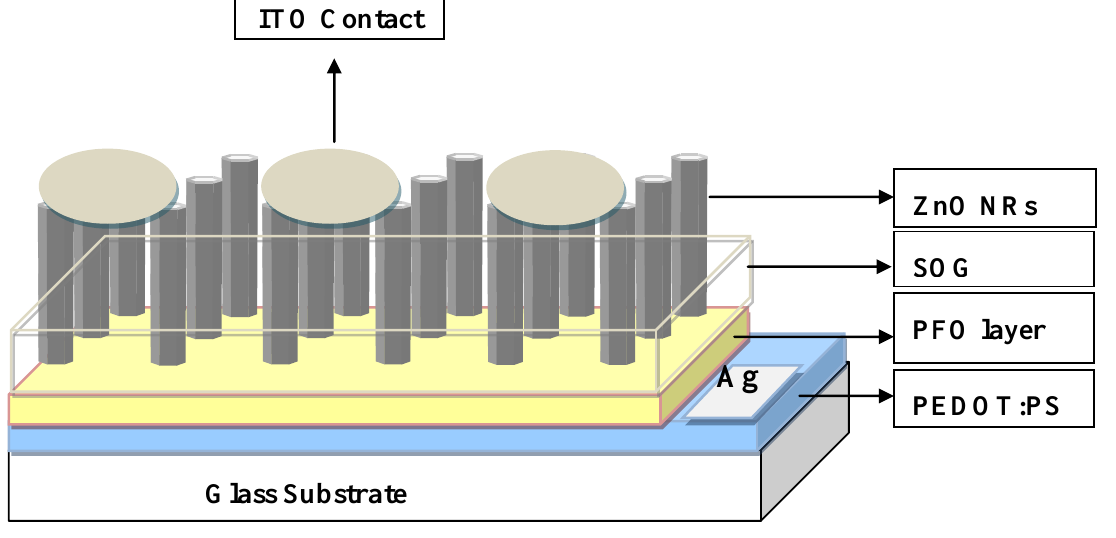
ZnO NRs SOG PFO layer PEDOT:PS S